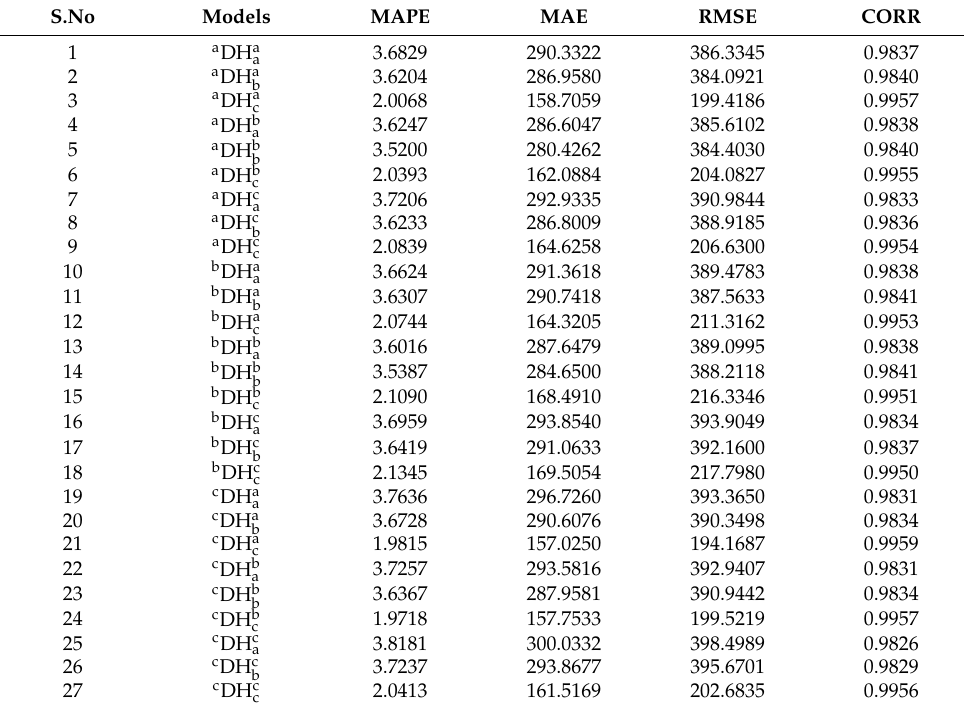
Table 3. Pakistan’s electricity consumption (kWh): out-of-sample one-month-ahead average forecast error for all models combined with the DH method.